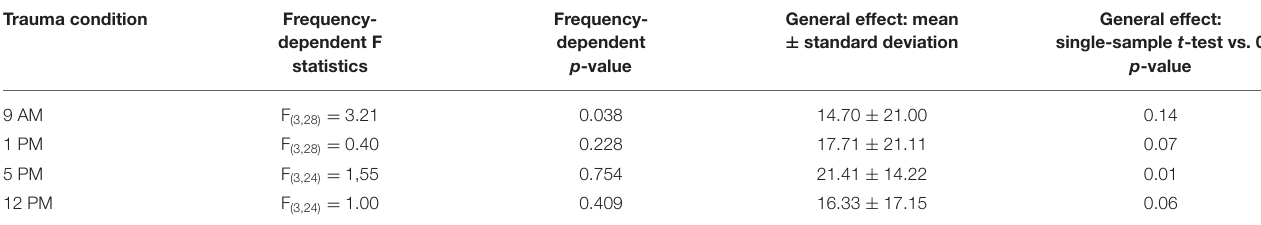
TABLE 1 | Statistics of one-factorial ANOVAs of HL over the different frequencies and single sample t -tests vs. 0 in the four trauma time conditions. Trauma condition Frequency-